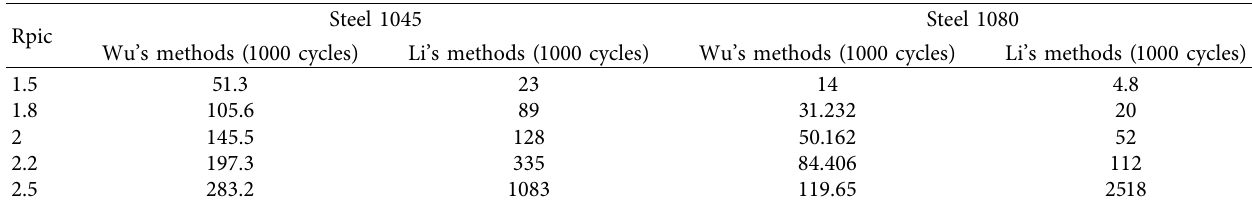
Figure 9: Comparison between experimental data and fatigue life estimated by the proposed method. Table 4: Fatigue life prediction by Wu’s and Li’s methods.